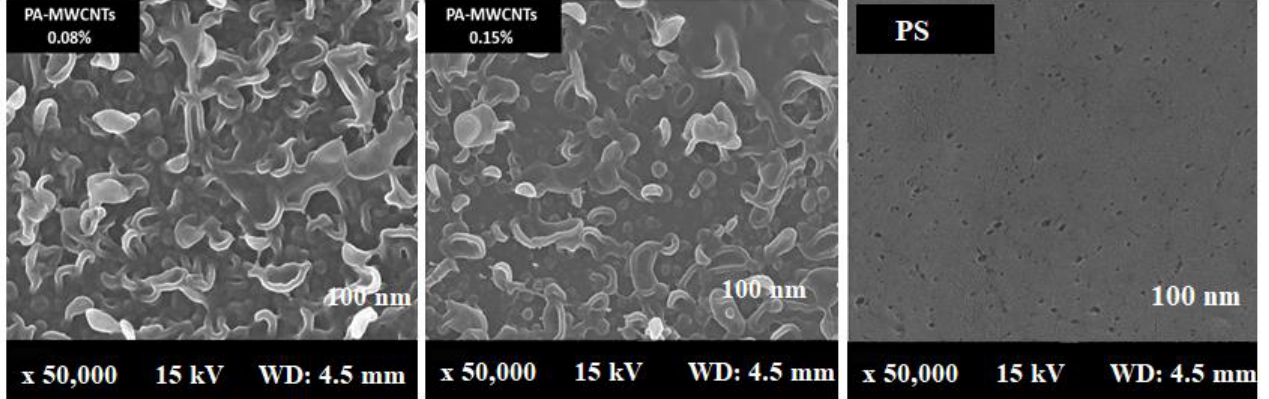
Figure 7. SEM images of the surfaces PA, PA-MWCNTs, and PS membranes.